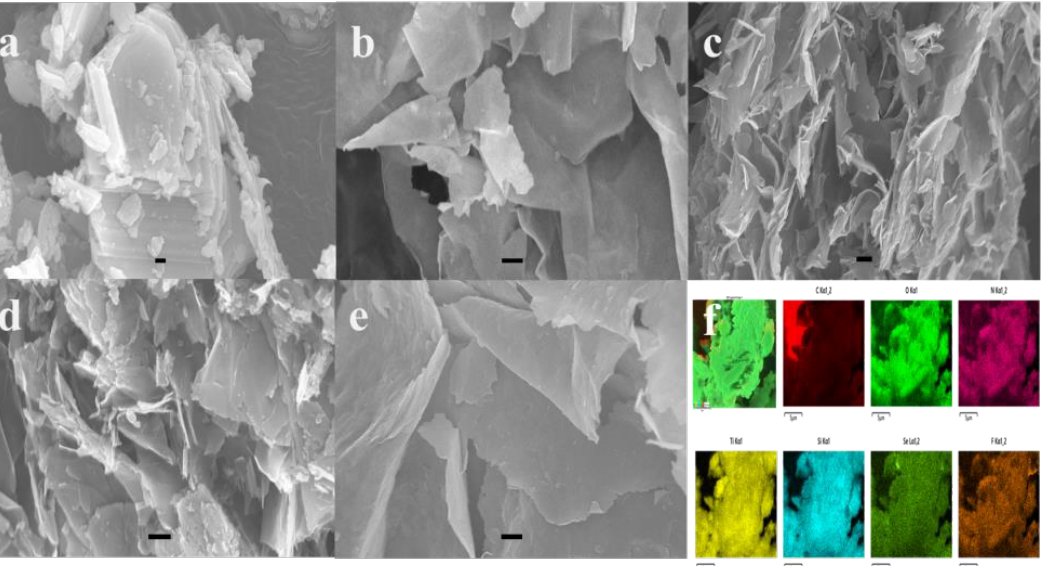
Figure 3. FE-SEM images of ( a ) Ti 3 AlC 2 , ( b ) MXene (Ti 3 C 2 ), ( c ) MXene -NH 2 , ( d ) MXene-Se, and ( e ) MXene-Se-DOX and ( f ) EDX mapping of MXene-Se-DOX. The scale bars for ( a – e ) are 300 nm, while the scale bar for ( f ) is 5 μm .